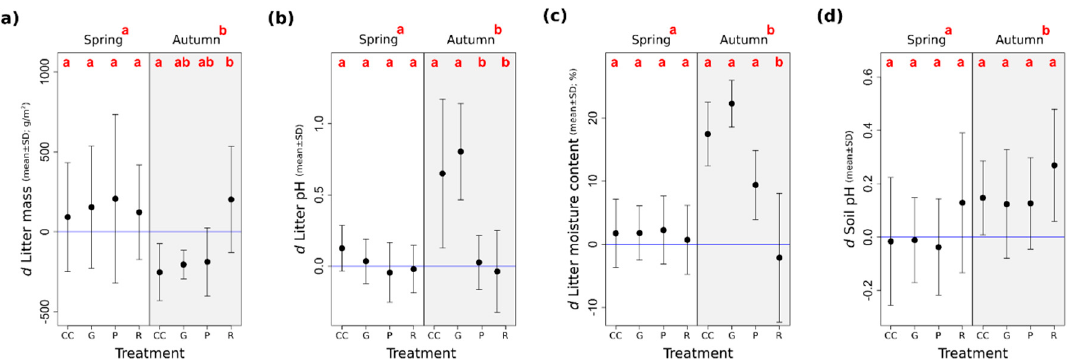
Figure 3. Temporal variability of the selected microclimate variables among the experimental treatments and months in the Pilis Mountains, Hungary, 2015. ( a ) Mean of the photosynthetically active radiation ([PAR] μ E m − 2 s − 1 ); ( b ) mean of vapor pressure deficit ([VPD] kPa); ( c ) mean of soil temperature ([T soil ] °C); ( d ) mean of soil moisture ([SWC] m 3 /m 3 ). The letter d in the variable abbreviations refers to the differences from the mean values measured in the control plots. Treatment types are coded as follows: CC—clear-cutting; G—gap-cutting; P—preparation cutting; R—retention tree group. Full circles show the mean and vertical lines denote the standard deviation of the samples. Letters designate the significant differences among the treatments and months (all of the pairwise multiple comparisons based on the linear mixed effects models: Tukey test, alpha = 0.05). The horizontal blue line shows the level of the control.